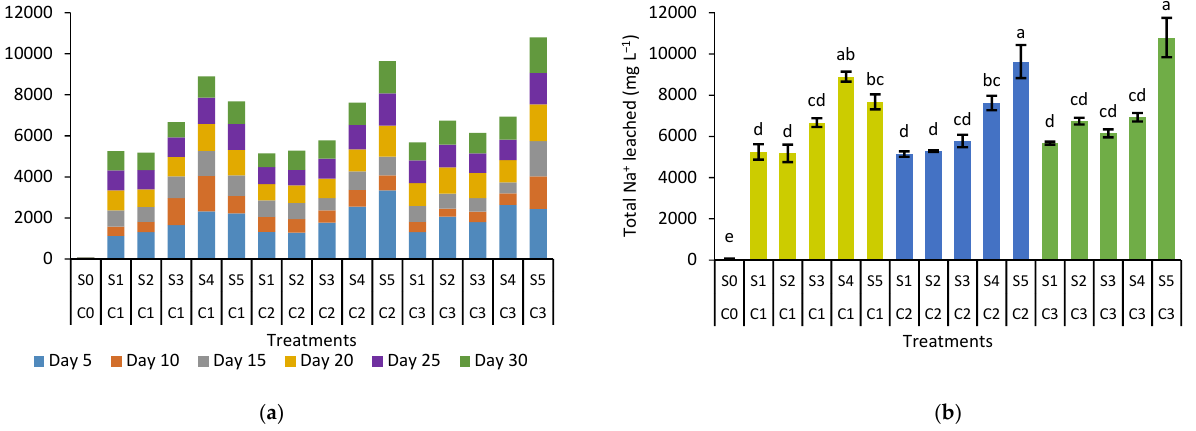
Figure 8. ( a ) Cumulative sodium in leachates at five day intervals and ( b ) total sodium in leachates for the different treatments after thirty days of leaching. Different letters indicate significant mean differences using Tukey’s HSD test at p ≤ 0.05. Error bars represent the standard error of the mean.